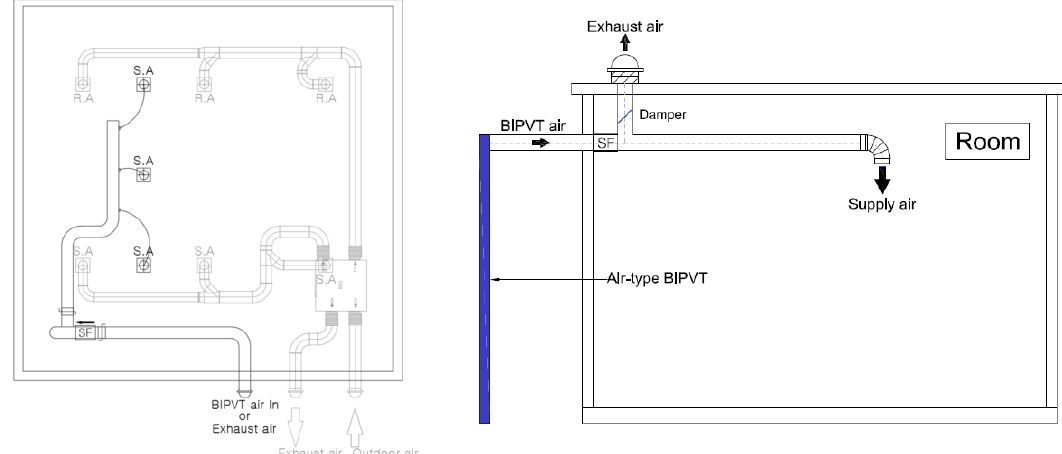
Figure 4. Classrooms using directly preheating air of air-type BIPVT collectors.